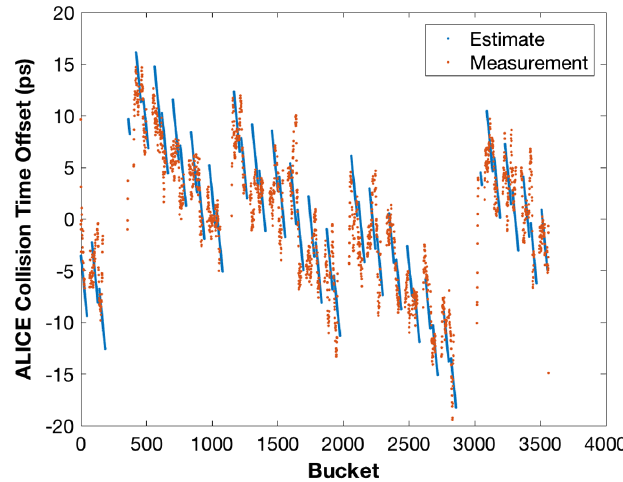
FIG. 24. Collision point time shift for the ALICE